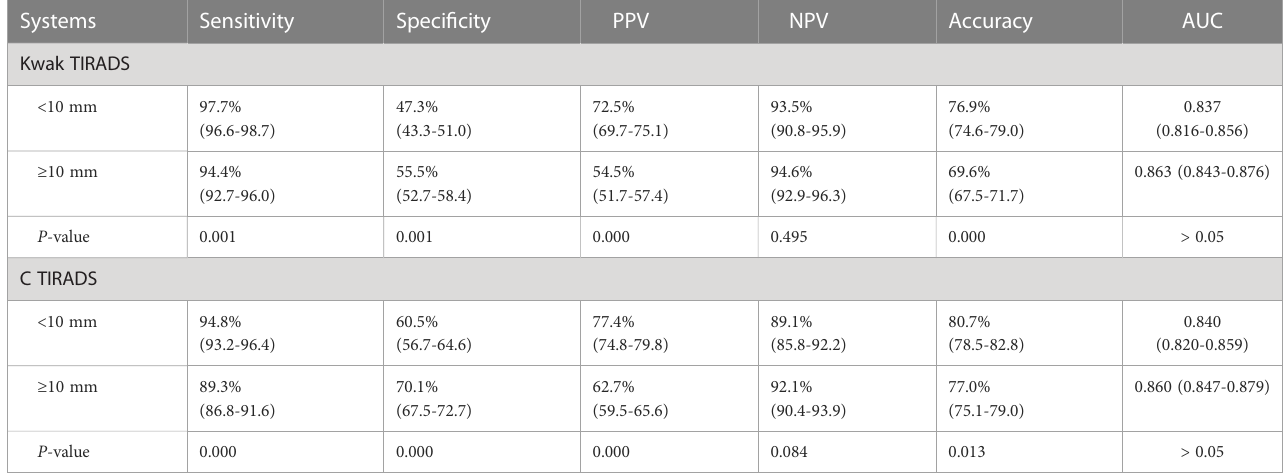
TABLE 6 Diagnostic performance in different thyroid nodule diameters between the Kwak and the C TIRADS. Systems